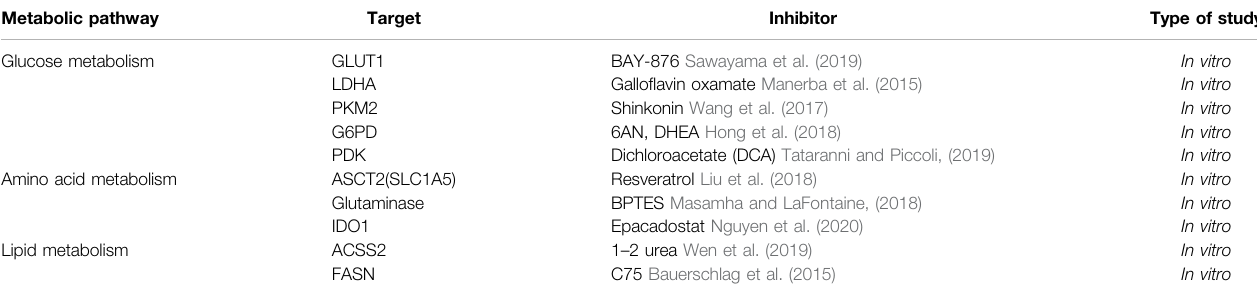
TABLE 2 | The inhibitor targeting metabolic alterations of cisplatin-resistant tumours. Metabolic